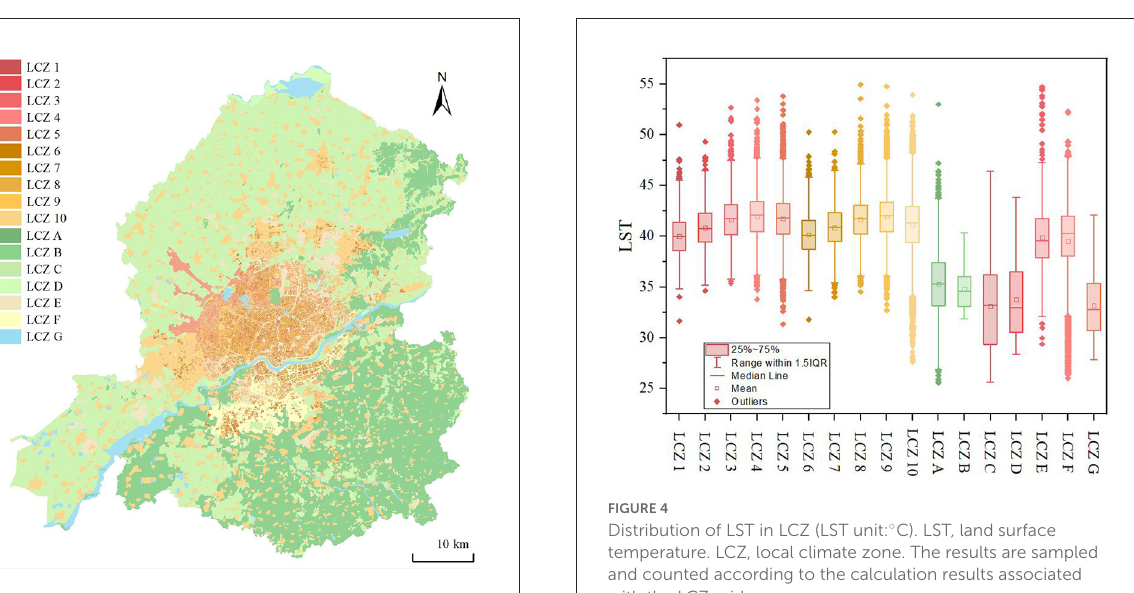
FIGURE2 LCZ distribution in study area. LCZ, Local climate zone.